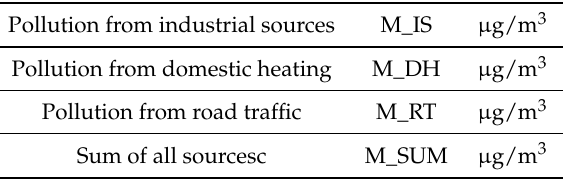
Table 3. Factors based on dispersion